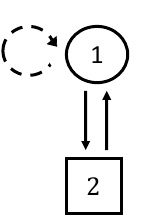
Figure 7 . The quiver diagram for the worldvolume theory on the D1-branes in the con(cid:12)guration in (cid:12)gure